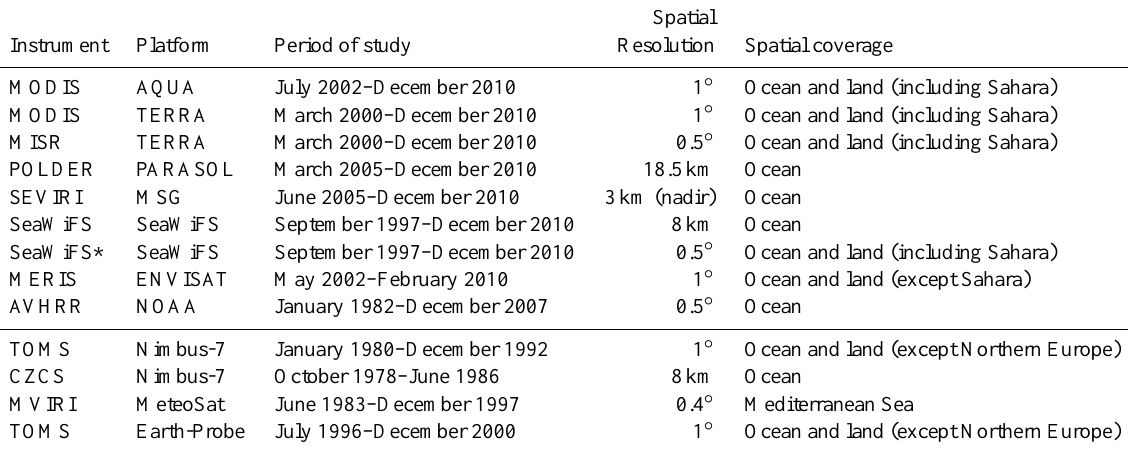
Table 1. Main characteristics of the different satellite sensors used in this study. Instrument Platform Period of study Resolution Spatial coverage